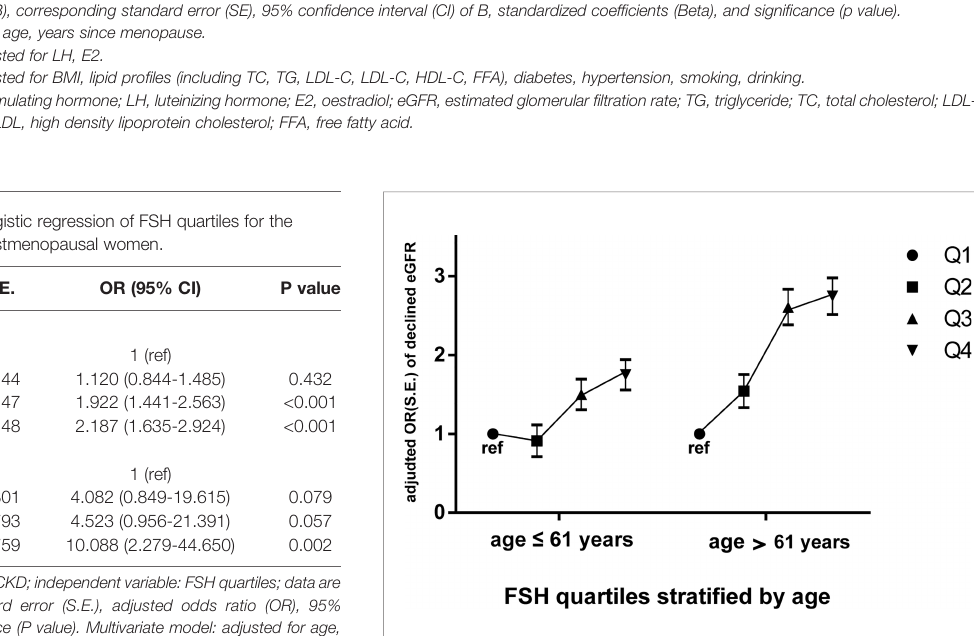
FIGURE 3 | Odds ratios (ORs) of declined eGFR with increasing FSH quartiles (expressed as Q1, Q2, Q3, and Q4) in postmenopausal women strati fi ed by median age (61 years). Dependent variable: declined eGFR; independent variable: FSH quartiles (Q1 as ref). Data are expressed as adjusted odds ratio (OR), standard error (S.E.). Multivariate logistic stepwise regression model: adjusted for age, years since menopause, LH, E2, BMI, dyslipidaemia, diabetes, hypertension, smoking, drinking. FSH, follicle- stimulating hormone; eGFR, estimated glomerular fi ltration rate; declined eGFR, eGFR<90 mL/min/1.73m 2